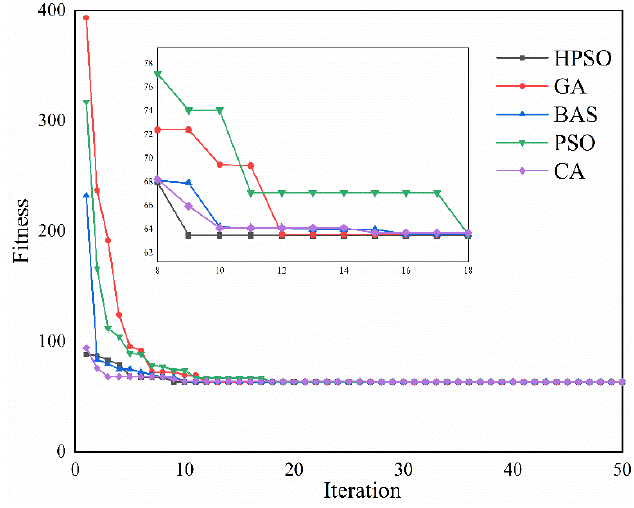
Figure 3. Comparison of evolution curves of different metaheuristic algorithms.